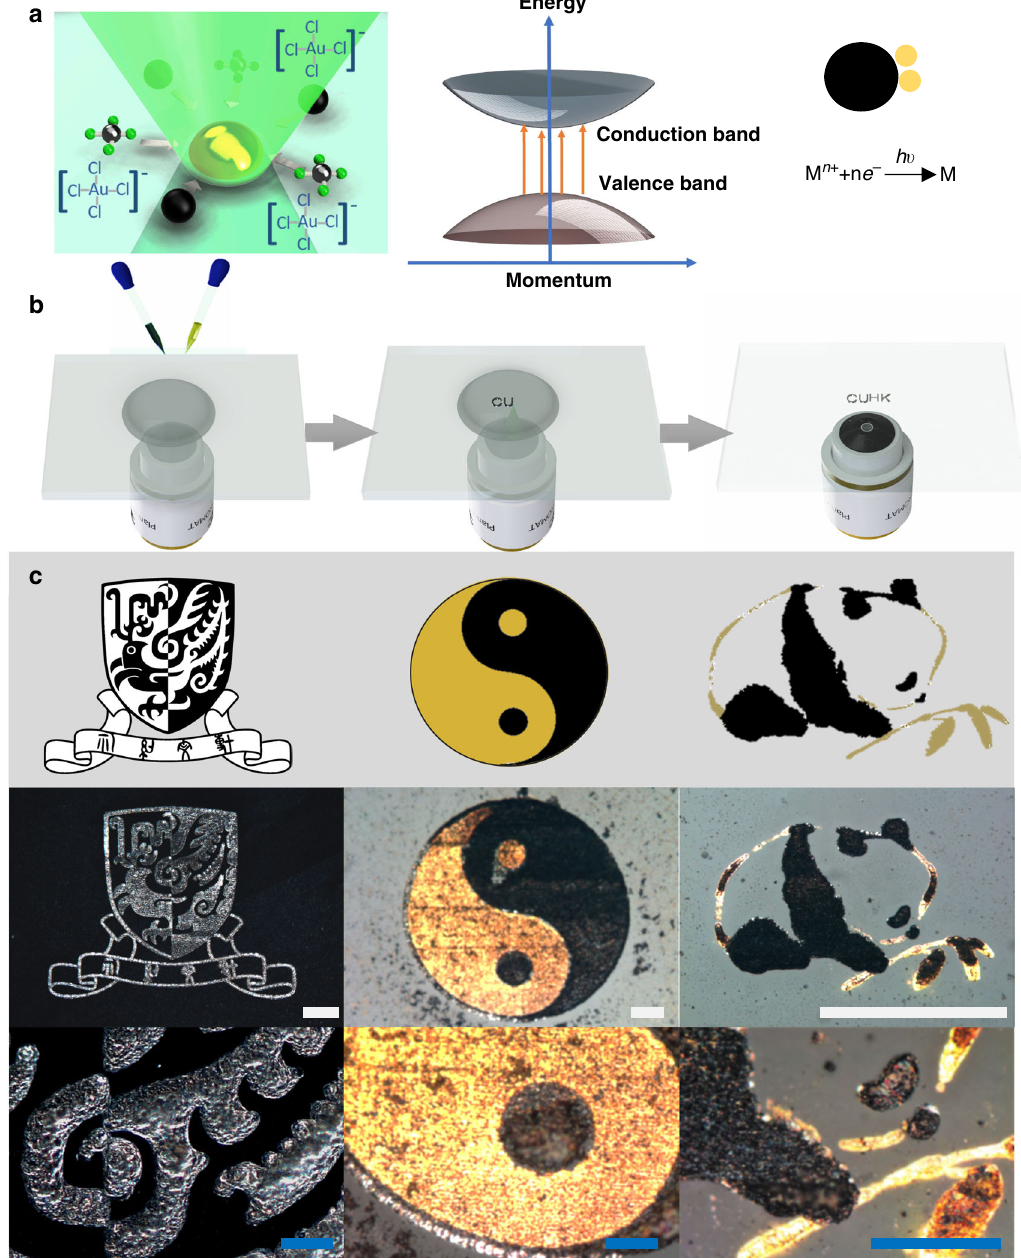
Fig. 1 Laser-induced material deposition. a schematic illustrations of the principle of the LIMD method. (left) Schematic illustration of the material deposition process, i.e., under the optical fi eld, the semiconductor nanoparticles are trapped towards the focus and on their surface photo-induced reduction reaction converts the metal ion into metal deposition. (middle) Ideal band structure of semiconductor particles. A photon excites an electron from the valence band into the conduction band to become the free electron which triggers the photo-induced reduction reaction. (right) Schematic illustration of the photo-induced chemical reduction process. Free electrons excited by photons in the semiconductor particle (black sphere) reduce metal ions into metal particles (yellow spheres) on the surface of the semiconductor. b schematic illustrations of the experimental procedure. (left) Drop-casting the thoroughly mixed reagents on the substrate surface, with one pipette containing metallate and the other containing semiconductor nanoparticles. (middle) a 532 nm laser beam, focused by a microscope objective, creates deposition in the focal spot. (right) After the deposition and washing with water, the deposited pattern is left on the substrate. c three samples of depositions on glass slides done with the LIMD method. The designs are shown in the upper row. The images in the lower row are the detail zoom-ins of the middle row. (left) A logo of CUHK written in platinum. (centre) A yin-yang symbol written with platinum and gold. (right) A Chinese traditional ink painting written with platinum and gold. The white scale bars represent 50 μ m, the blue ones represent 25 μ